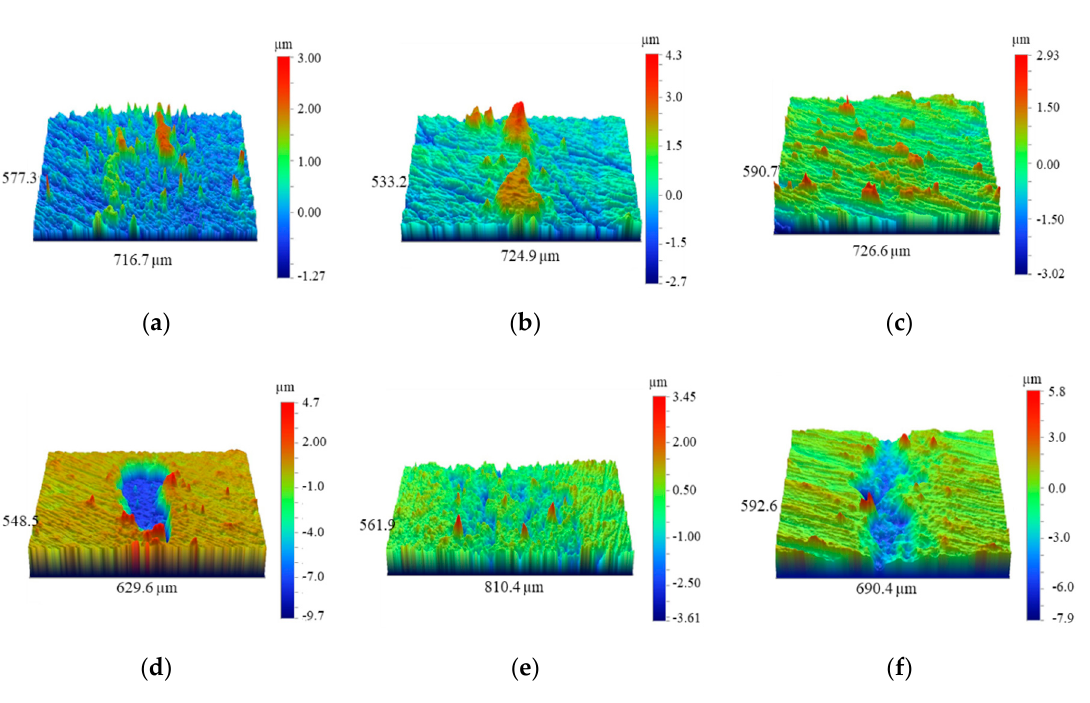
Figure 5. 3D images of wear tracks on the surface of coatings 1(Ar), 2 (5 sccm N 2 ), and 5 (10 sccm C 2 H 4 ) after testing against 100Cr6 ( a – c ) and Al 2 O 3 ( d – f ).